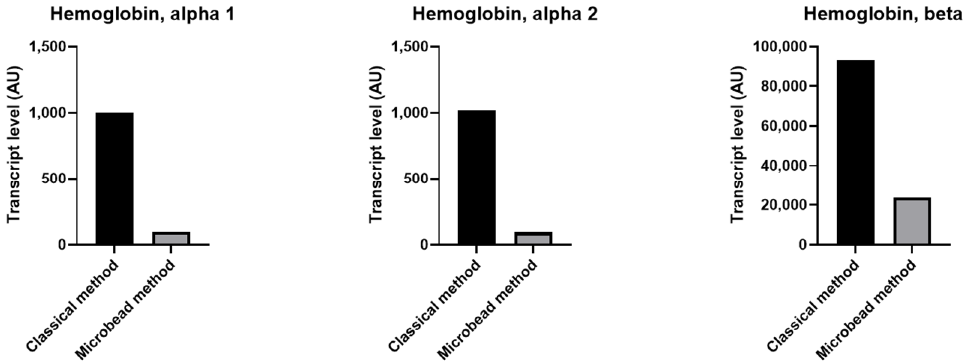
Figure 4. Increased relative level of transcripts related to erythrocytes in platelets purified without magnetic microbeads. Histograms presenting transcript levels for a number of erythrocyte genes, detected by microarray in platelet preparations purified with or without magnetic microbeads. Data were analyzed using RMA algorithm and TAC software. Different transcript levels with a fold change higher than 2 or lower than − 2 were retained.